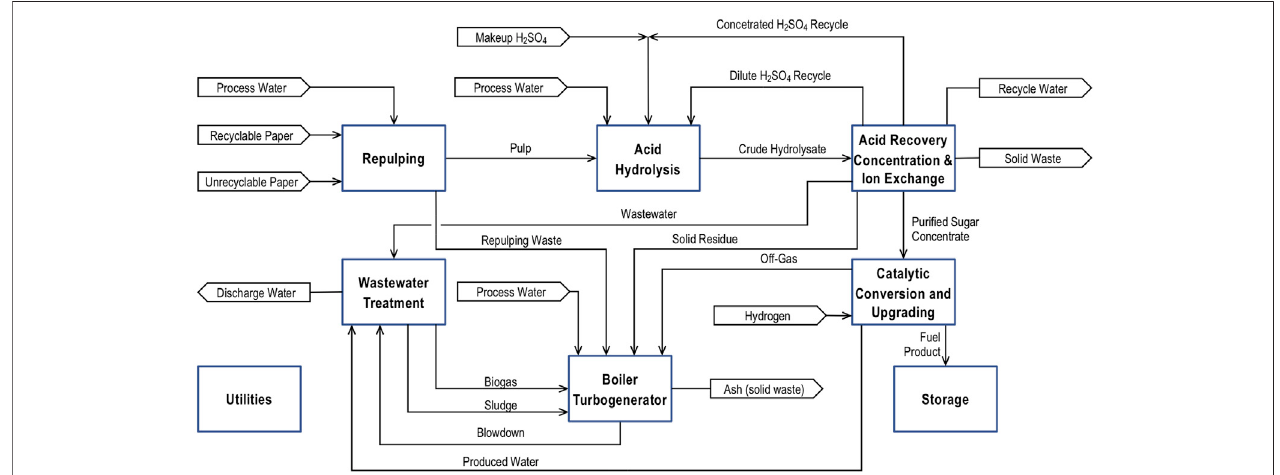
FIGURE 4 | A block diagram of a process for converting recycle paper into jet fuel with acid